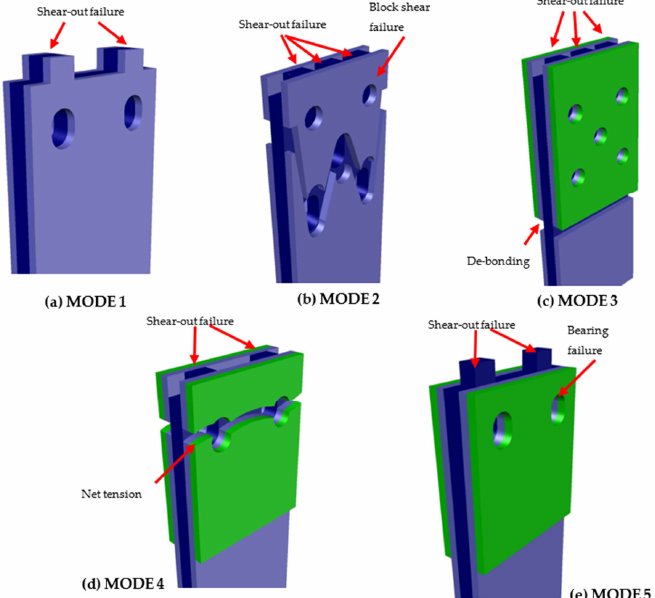
Figure 6. Failure modes of the PGFRP connections.: ( a ) MODE1, ( b ) MODE2, ( c ) MODE3, ( d ) MODE4, ( e ) MODE5.